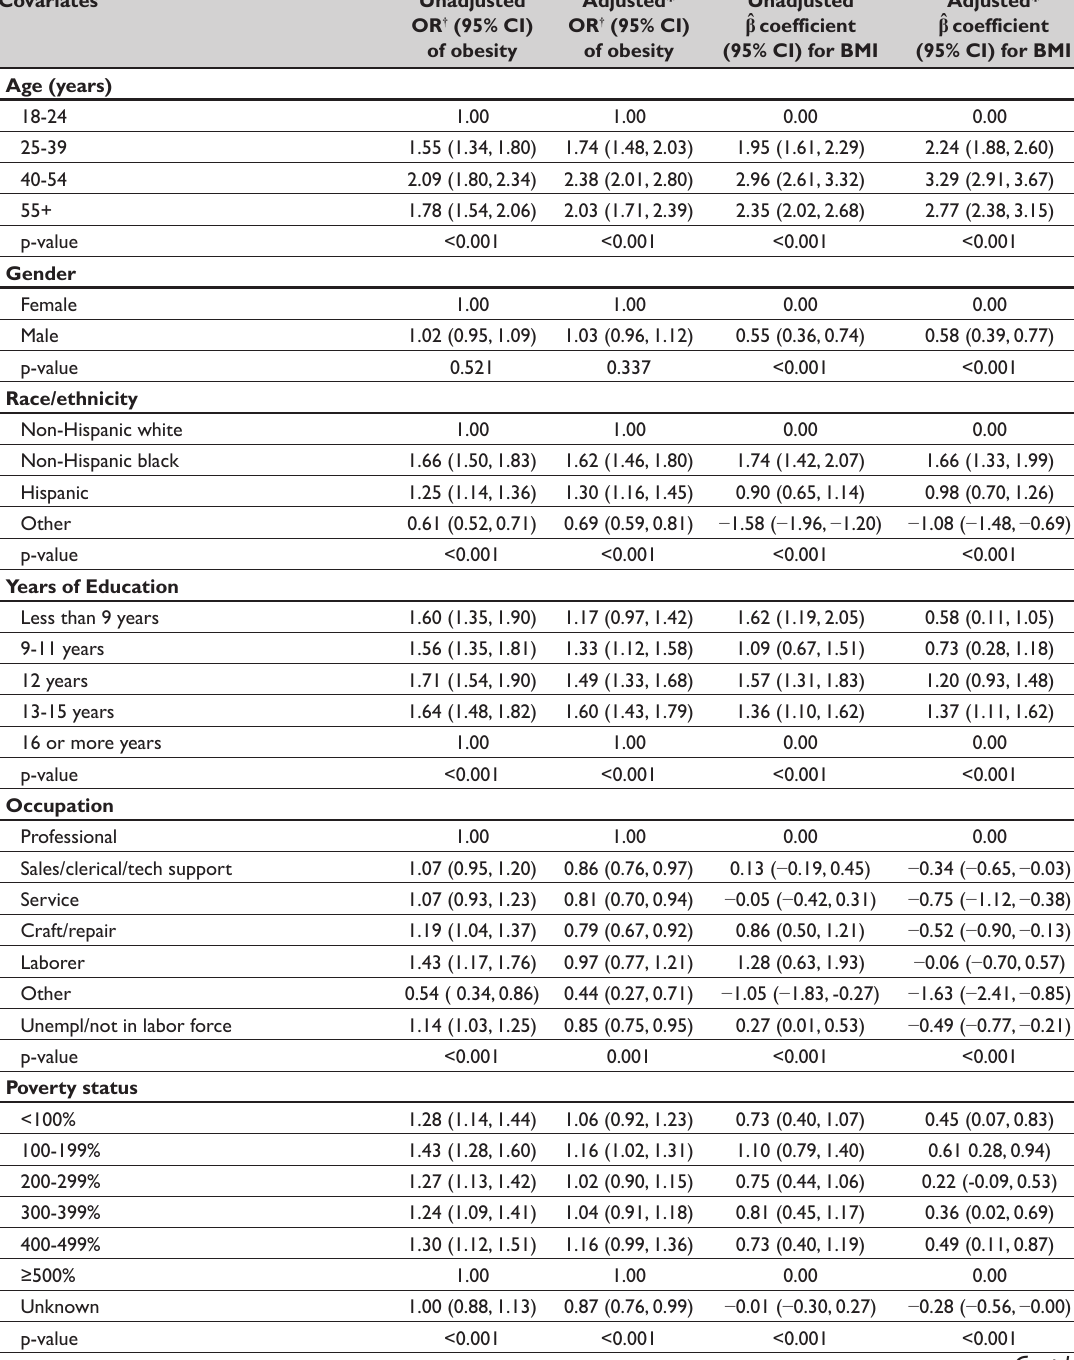
Table 2. Regression of Obesity and BMI on Covariates